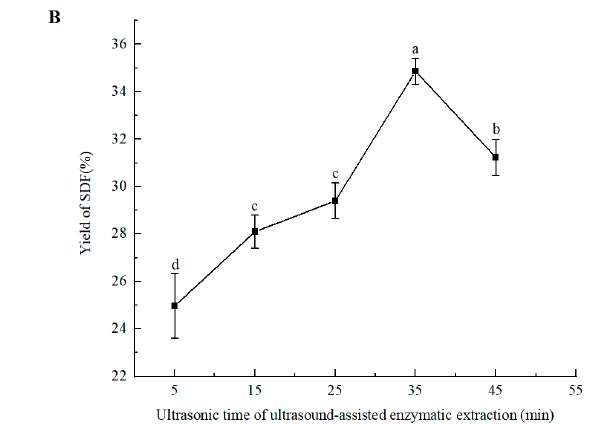
Figure 2. The influence of cellulase dosage ( A ) and ultrasonic time ( B ) on the extraction yield of ultrasound-assisted enzymatic extraction on SDF. Different letters on top of the error bar indicate significant ( p < 0.05) differences among samples treated under different conditions.